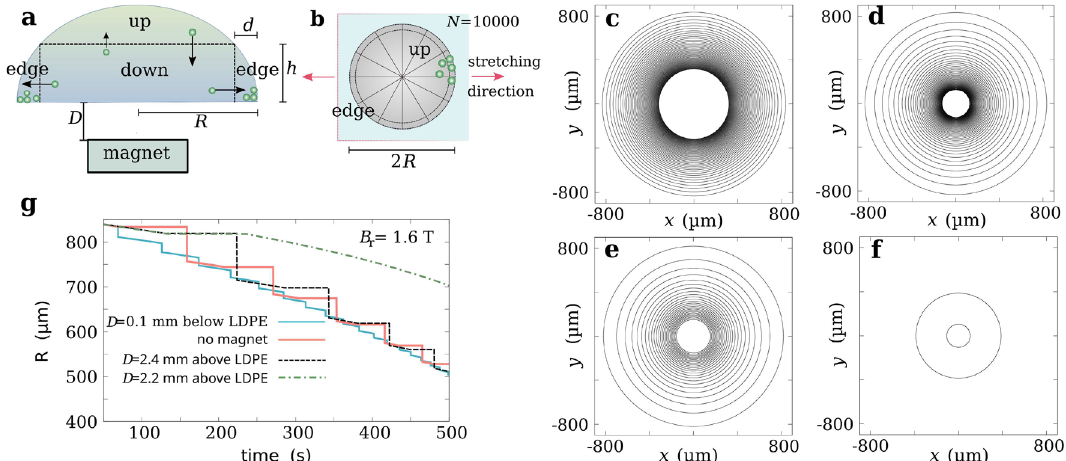
Figure 6. Theoretical model scheme and results. ( a ) Cross-section of a magnetic liquid droplet with a coarse- grained division into two layers: the lower part with the “down” area and the “edge” area, where the outward drift of magnetic nanoparticles takes place due to the droplet evaporation, and the upper part representing the “up” area. When a magnet is located below the droplet an extra drift of magnetic nanoparticles from the area “up” to “down” is present, otherwise, for the magnet above the droplet, the nanoparticle drift from “down” to “up” is present. ( b ) Division of the droplet volume into N units with the effective viscosity at the bottom layer that depends on the orientation concerning for the stretching direction. ( c ) Multi-ring deposit for a magnet 0.1 mm below the LDPE film, ( d ) Multi-ring deposit without the presence of a magnet, ( e ) at distance D = 2.4 mm above the LDPE film, ( f ) Same as for case ( e ) but Multi-ring deposit for a magnet at distance D = for D 1.6 =